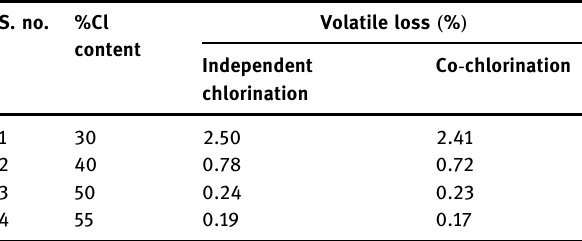
Table 6: Comparison between volatile loss in chlorinated para ffi n obtained via independent chlorination and co - chlorination S. no. %Cl